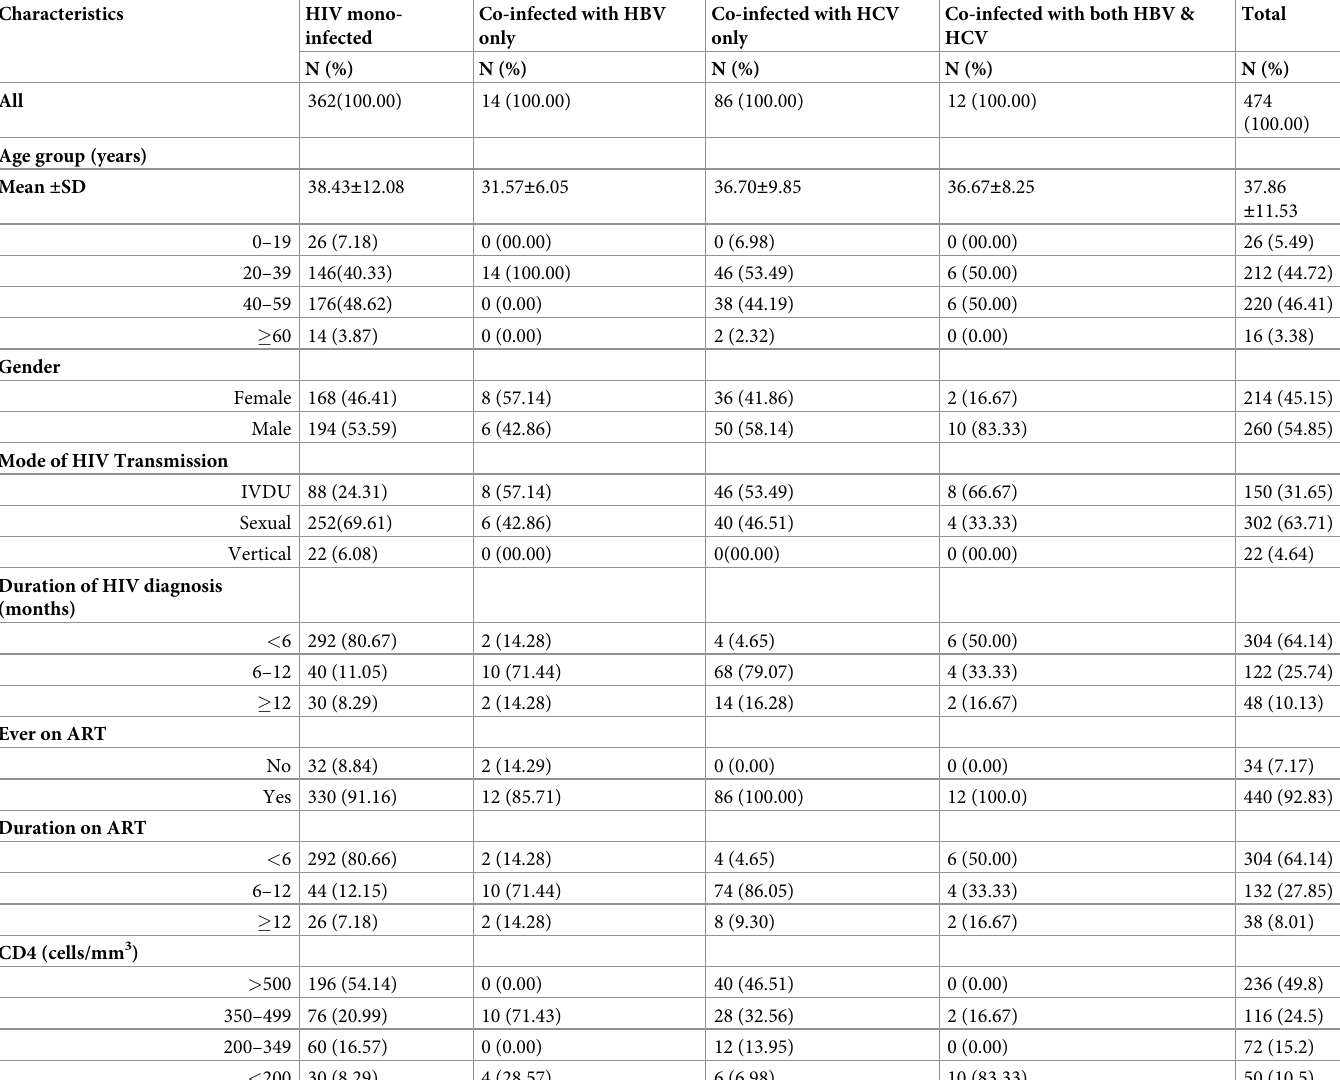
Table 1. Demographic and clinical characteristics of HIV patients with mono-infection and HBV and/or HCV co-infections (N = 474).